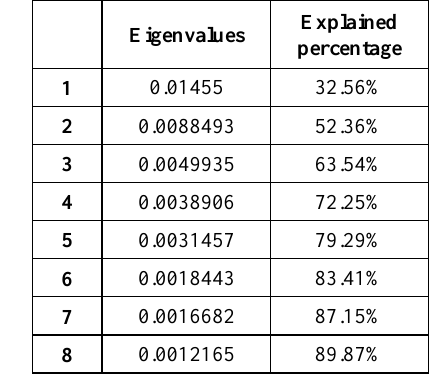
Table 3: PCA Results